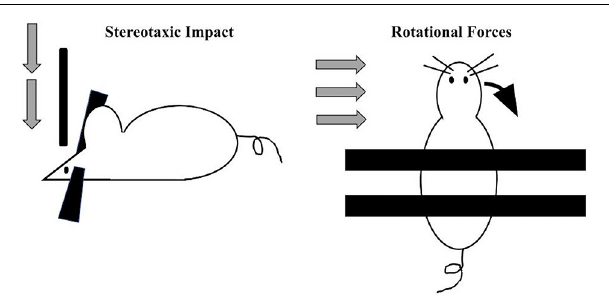
FIGURE 2 | Two main approaches utilized preclinically to apply standardized and precise trauma to rodents include the stereotaxic approach (left) where a head-restrained rodent receives a vertically oriented impact of a specific velocity, force, and dwell time. More recently, to more closely model blast and other accelerative forces, a standardized rotational impact can be applied (right) by restraining the body and not the head, resulting in angular acceleration of the head along either the mediolateral axis (when applied laterally (Goldstein et al., 2012; Logsdon et al., 2017; Chen M. et al., 2018) or along the anteroposterior axis [when applied vertically (Namjoshi et al.,